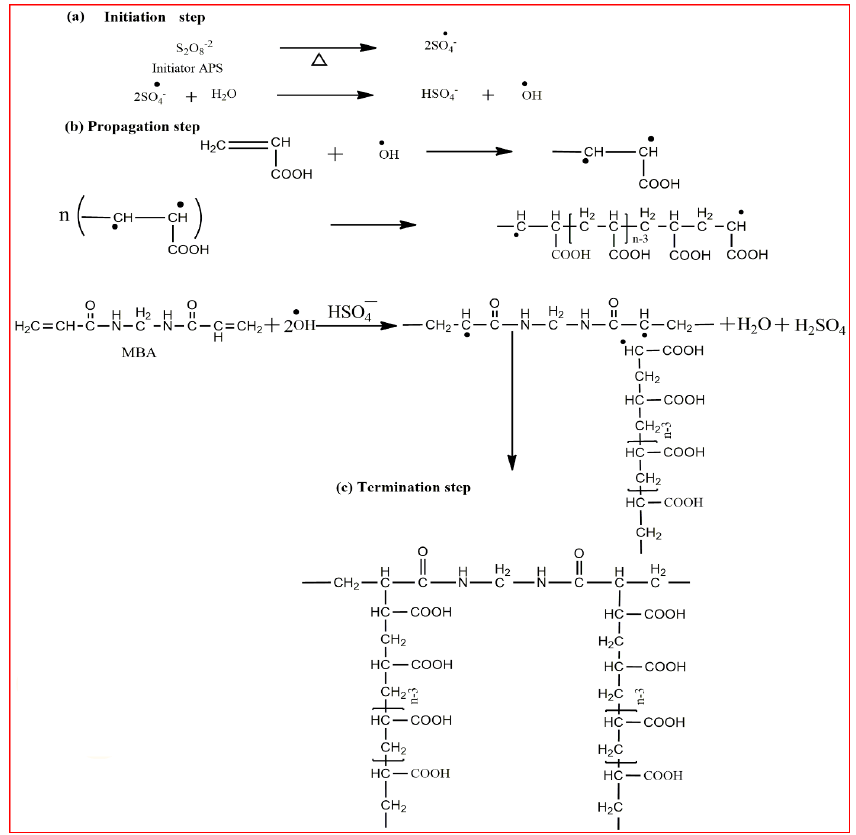
Figure 2. The reaction mechanism of the poly (acrylic acid) hydrogel [38] .